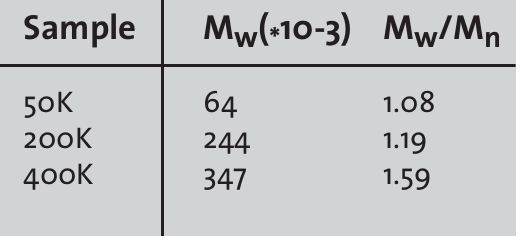
Table 1: Molecular charac- teristics of polybutadiene samples.